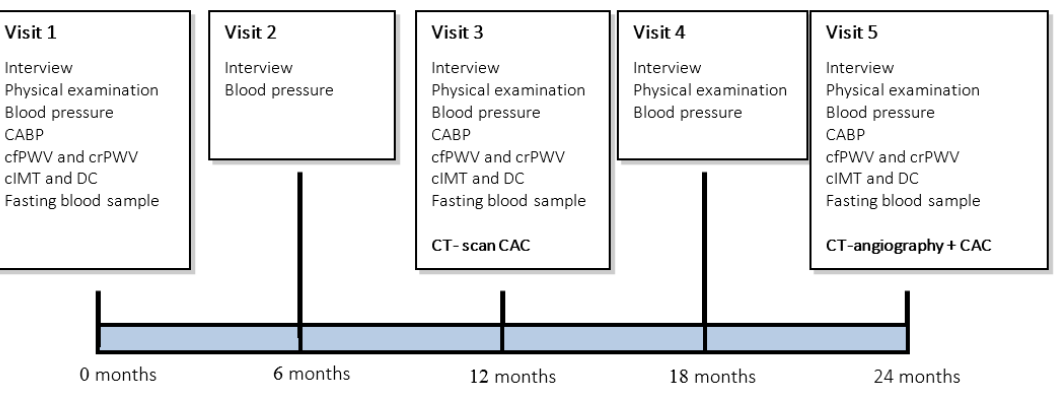
Figure 1. Trial Figure 1. Trial design.